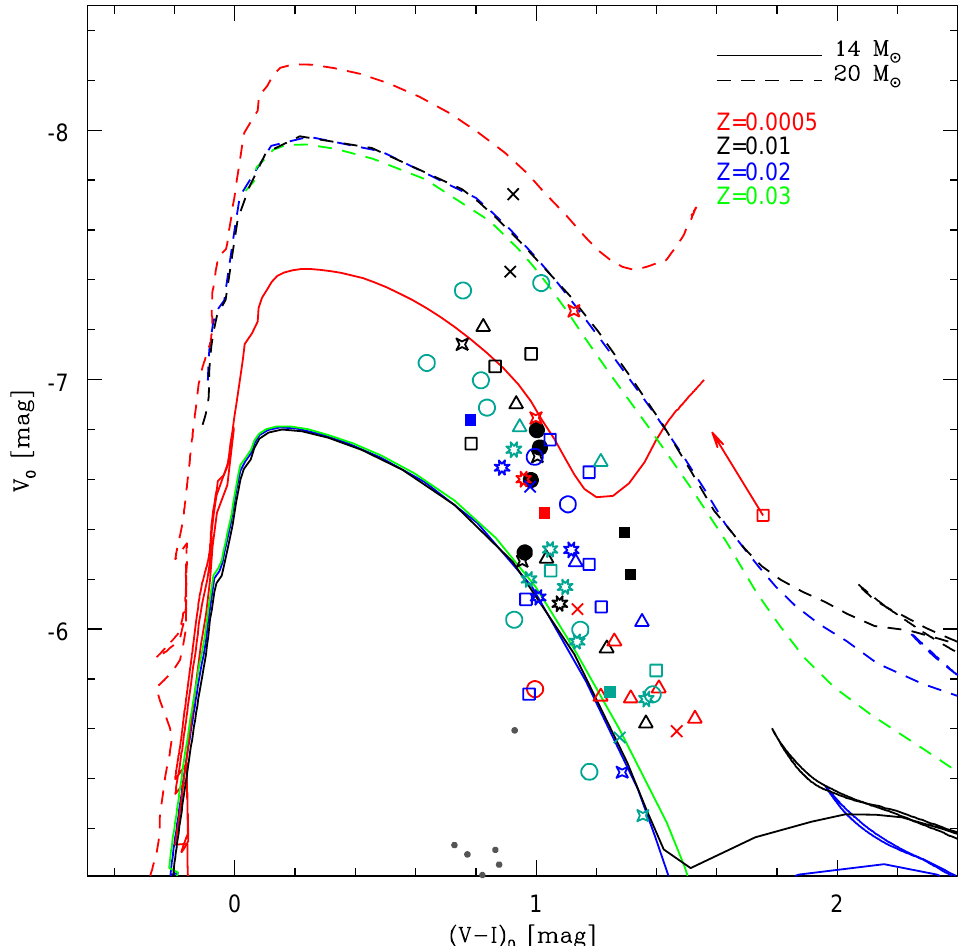
Figure 6. CMD V 0 versus ( V − I ) 0 for our ULP sample (the symbols for the ULPs are the same as adopted in Figure 1, whereas the red arrow is explained in Figure 4). The stellar tracks for 14 (solid line) and 20 (dashed line) M (cid:12) and for different metallicities ranging between Z = 0.0005 and 0.03 are plotted (see labels in